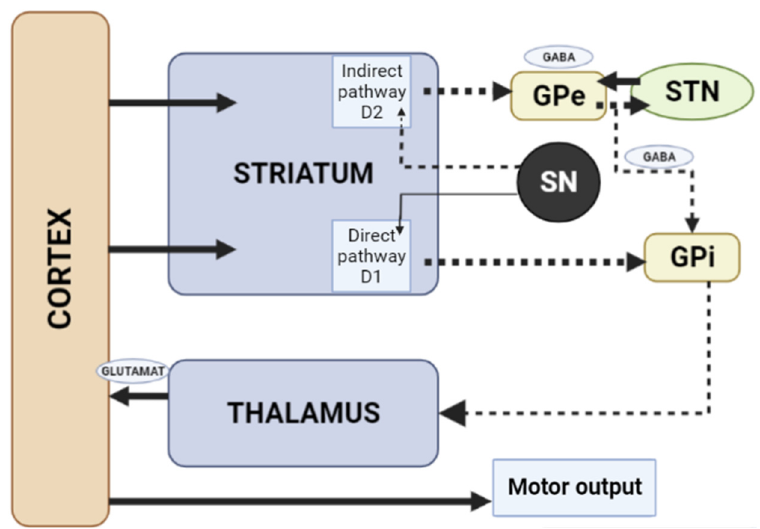
Figure 3. Schematic diagram of the excitatory and inhibitory ganglia involved in the development of AIP (Adapted from [25], Copyright year 2020, BMJ Neurol. Open). Note: Substantia nigra dopaminer- gic projections exert an exciting effect on stria-pallidal fibers of the direct pathway through dopamine D1 receptors, which leads to disinhibition of the thalamic nuclei and increased thalamocortical excitation, facilitating movements initiated by the cortex. The obstruction of voluntary movement occurs due to thalamic inhibition, due to the inhibition of stria-pallidal fibers in an indirect pathway through dopamine D2 receptors. The direct pathway is due to the activation of glutamate neurons in the sensorimotor cortex, and the indirect pathway is due to the activation of GABA-ergic neurons. The dotted line shows the inhibitory action due to the action of GABA. The straight line shows the excitatory effect due to the action of